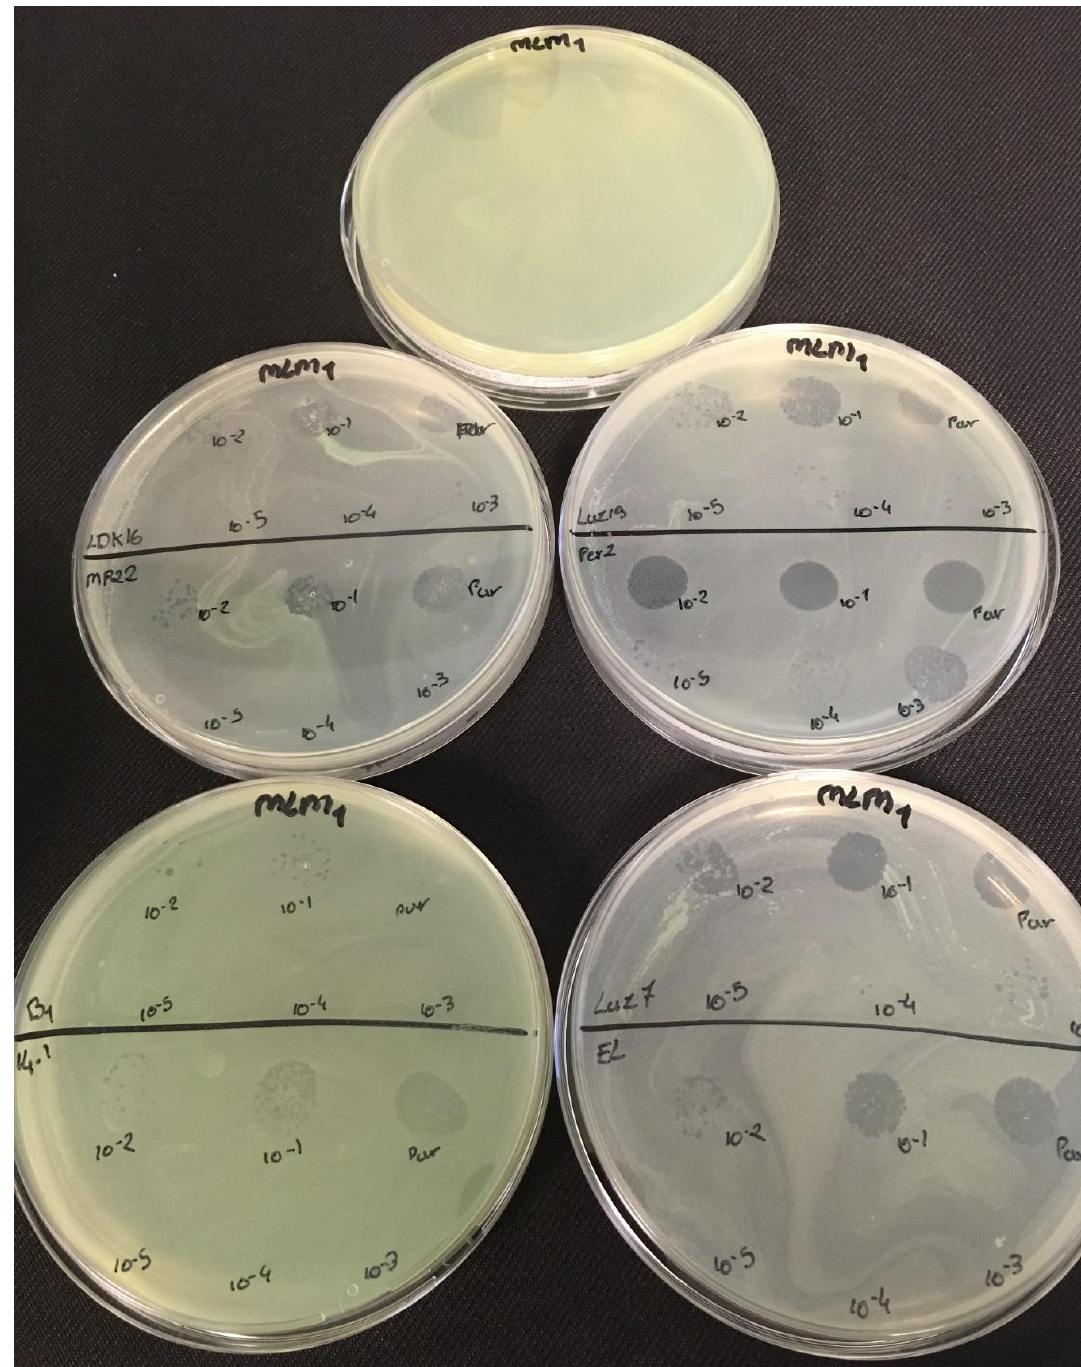
Figure A5. Plaque lysis forming from one spot test assay on MLM isolate with diluted phage suspensions. Each plate corresponds to the plaque lysis from two tested phages. The first plate at the top of the picture corresponds to the growth control of the isolate without phages.